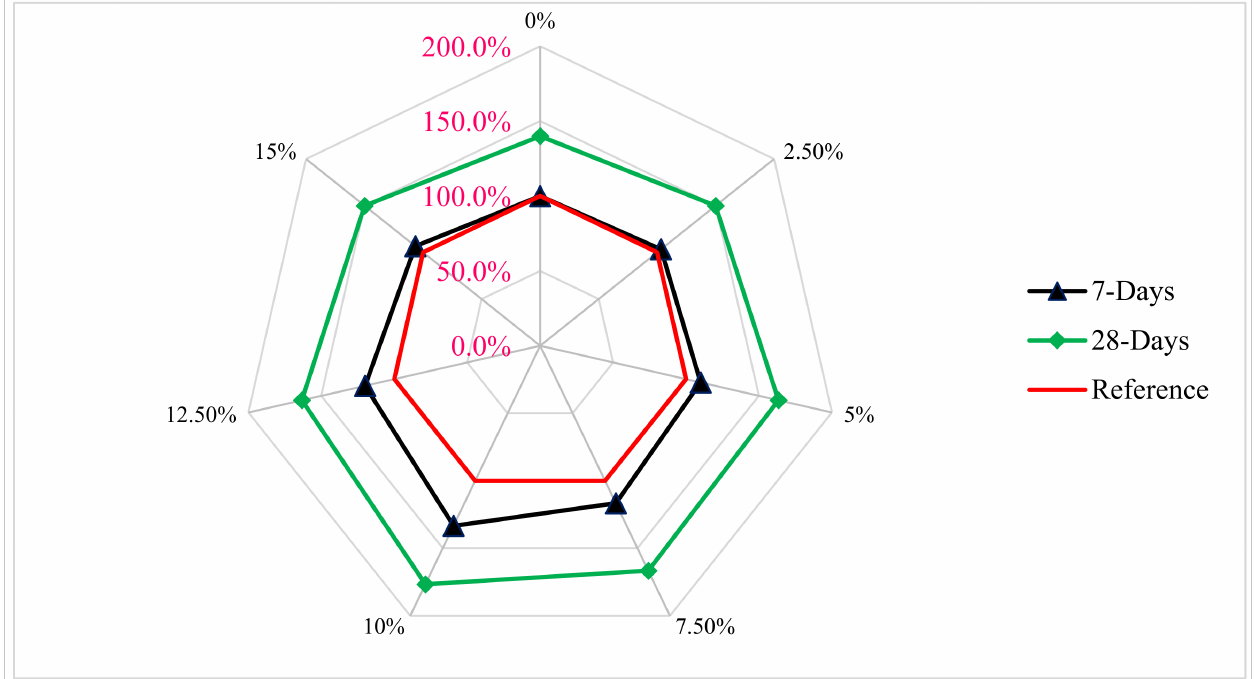
Figure 10. Relative Strength: Data Source